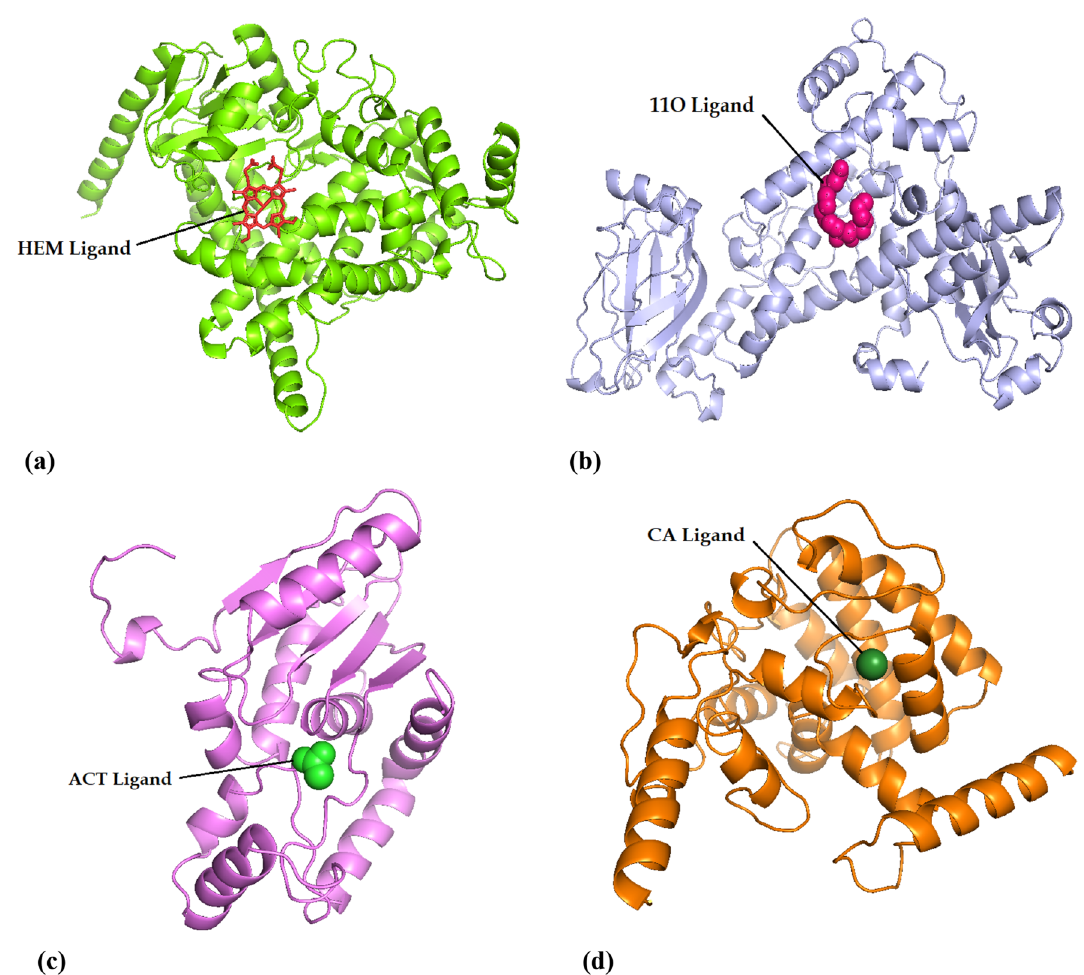
Figure 9. Cartoon representation of selected proteins interaction with their ligands. ( a ) CYP86 protein with HEM ligand. ( b ) LOX2 protein with 11O ligand. ( c ) PAL protein with ACT ligand. ( d ) PXG3 protein with CA